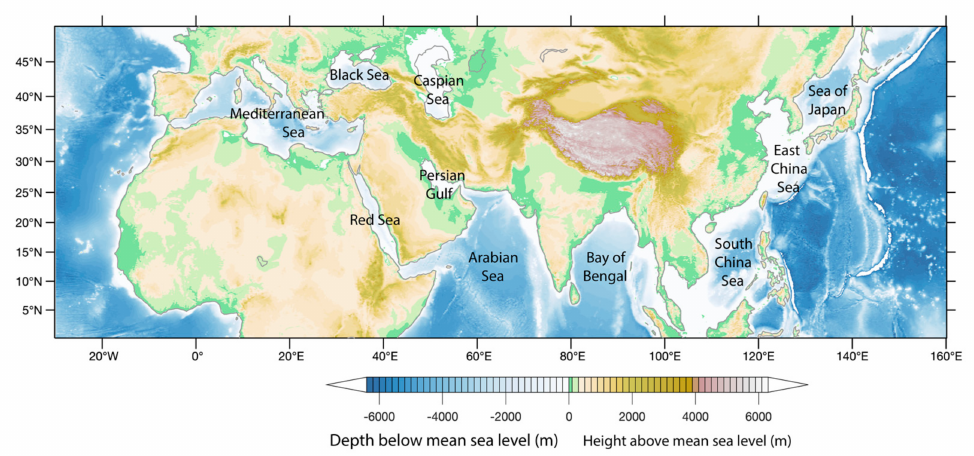
Figure 1. The 10 major semi-enclosed and enclosed marginal seas that surround the Eurasian continent. Left to right: the Mediterranean Sea, the Black Sea, the Caspian Sea, the Red Sea, the Persian Gulf, the Arabian Sea, the Bay of Bengal, the South China Sea, the East China Sea, and the Sea of Japan. The colors denote ocean floor (blues and whites) and land (greens, browns, and